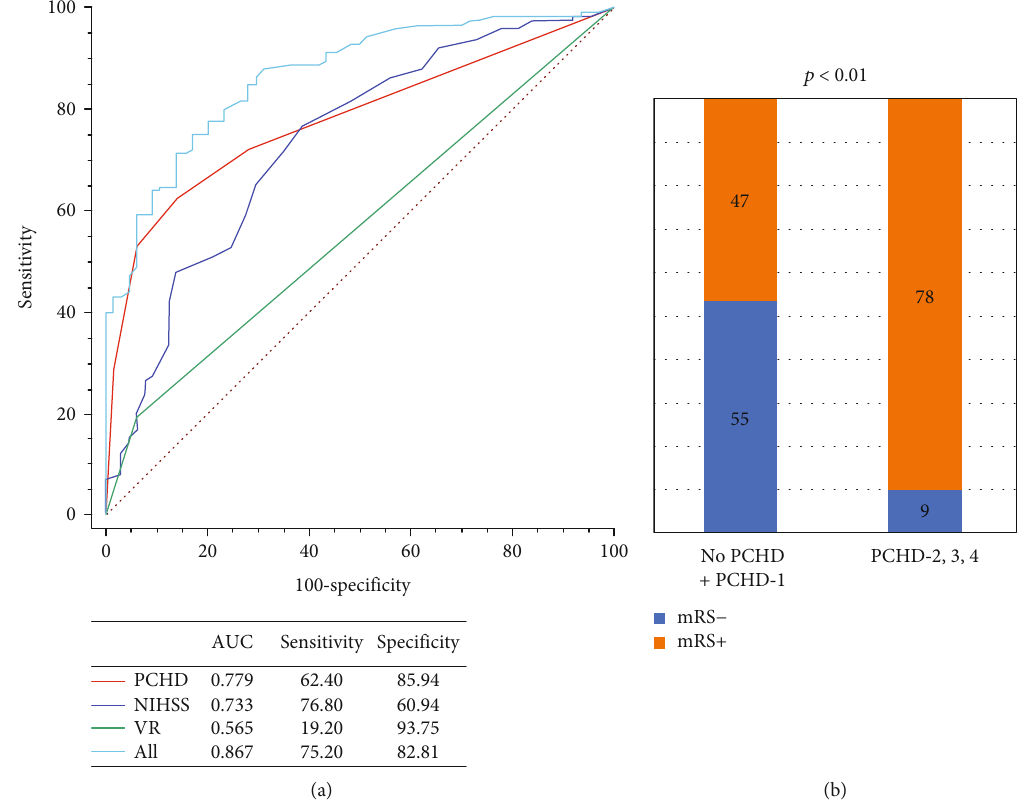
Figure 7: Evaluation of the accuracy of the mRS score at 3 months. (a) ROC curves for good vascular recanalization (VR), the NIHSS score at admission, and PCHD in predicting the mRS+ ( ≥ 3 score) at 3 months. (b) The probability of the mRS+ at 3 months in the high-risk group was signi fi cantly higher than that in the low-risk group, and the optimal diagnostic cuto ff value was PCHD > 1